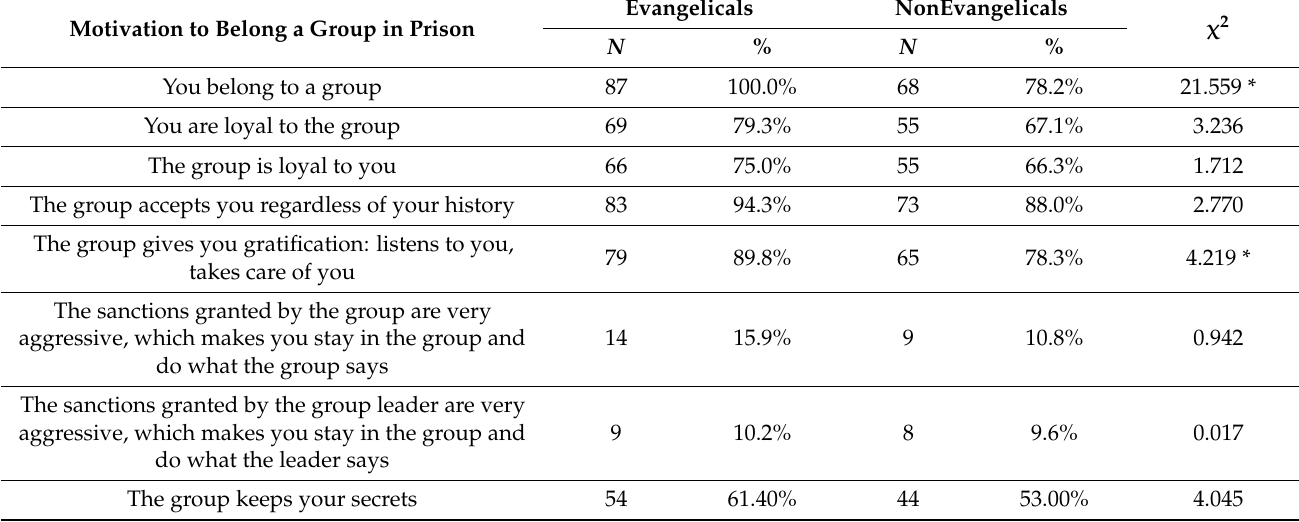
Table 3. Motivation to belong a group in